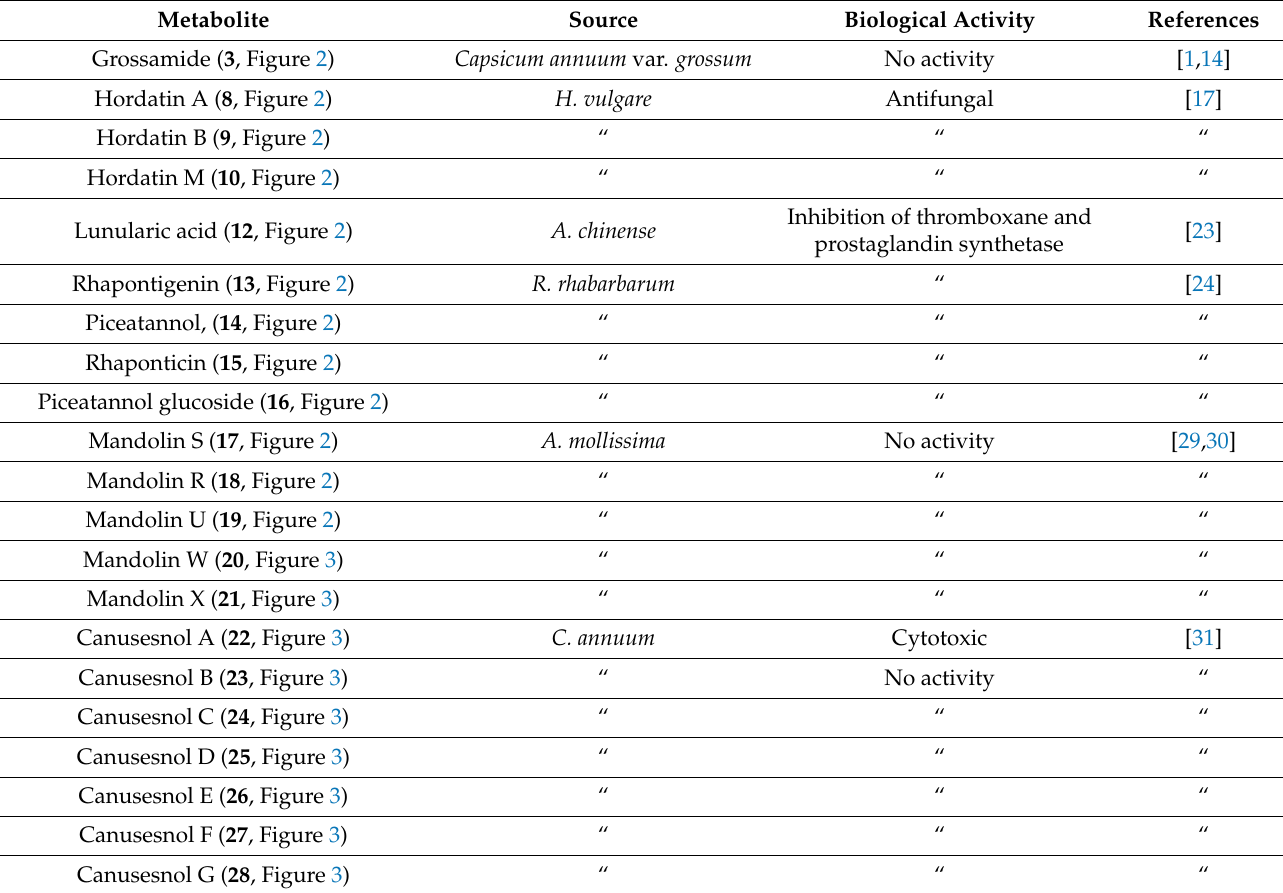
Table 2. Co-metabolites, their sources, and biological